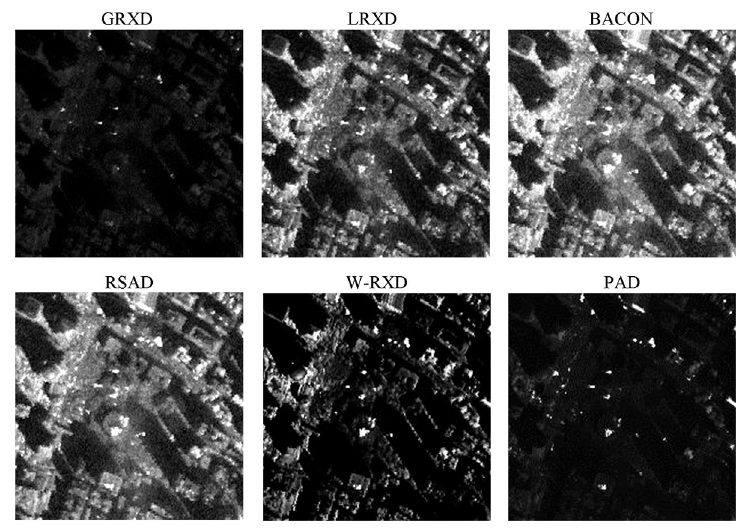
Figure 3. Detection results created by different algorithms with the WTC data.